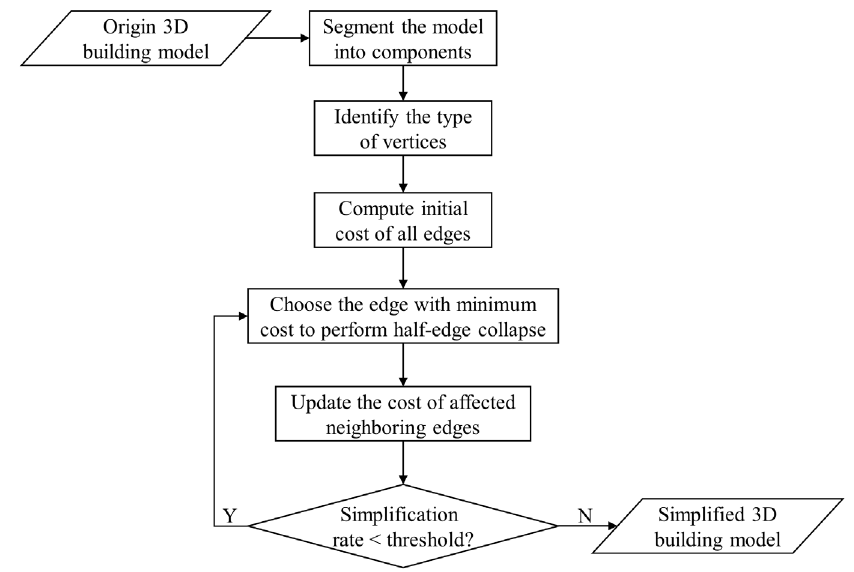
Figure 2. Flowchart of the proposed method.